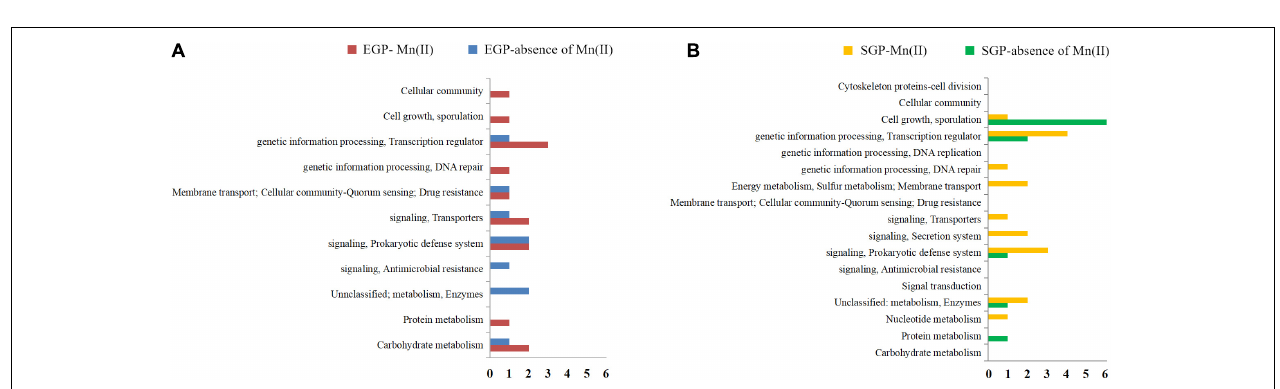
FIGURE 2 | Venn diagram showing the overlap of numbers of expressed genes in strain ST7 in the presence or absence of 250 mg/L Mn(II). Numbers of expressed genes in (A) exponential growth phase (EGP) and (B) stationary growth phase (SGP) are indicated.